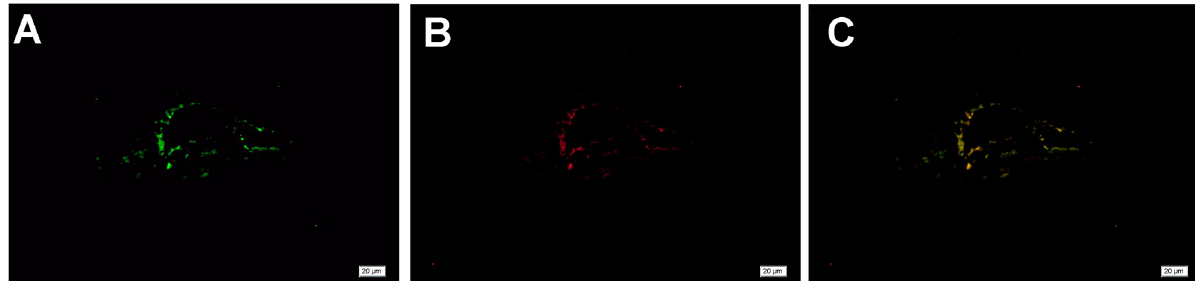
Figure 4. Double immunofluorescence staining images showing CD34/LYVE-1 expression in the brain tissue 3 days after pTBI. Expression of ( A ) LYVE-1 (green); ( B ) CD34 (red); and ( C ) merge (yellow).